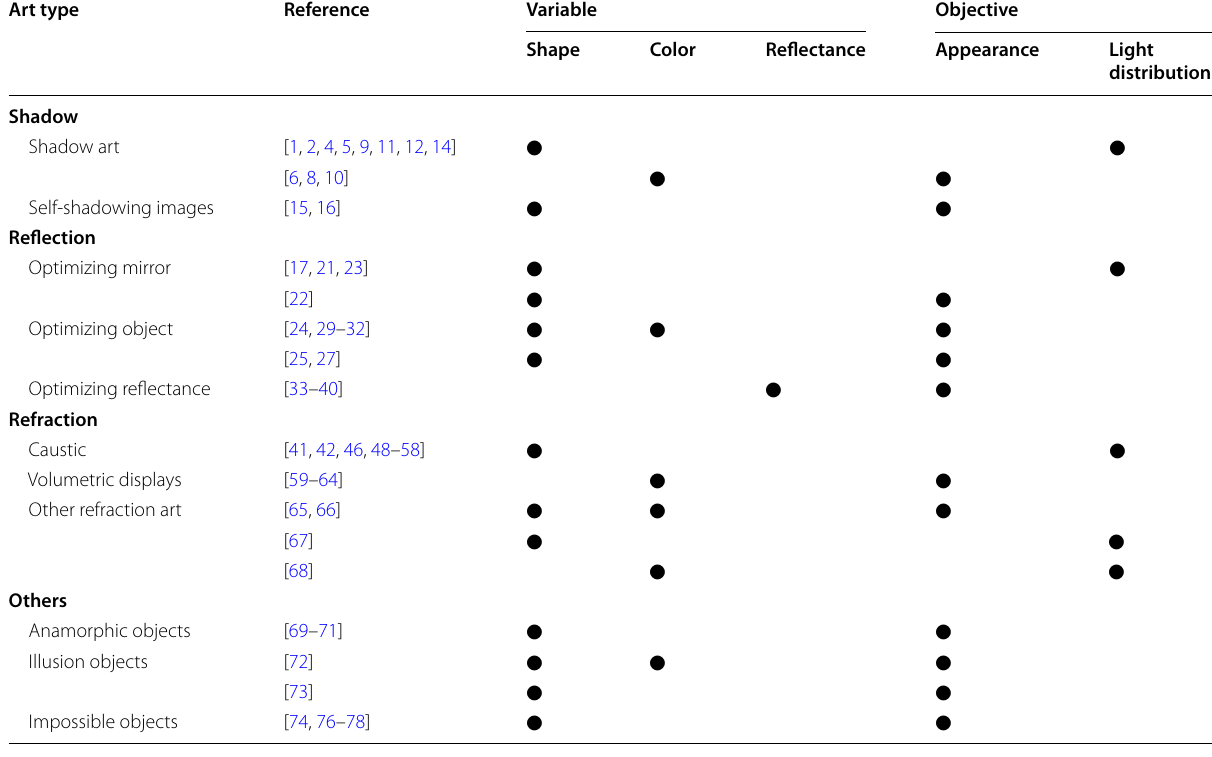
Table 2 We summarize the papers mentioned in this article for their optimization variables and target Art